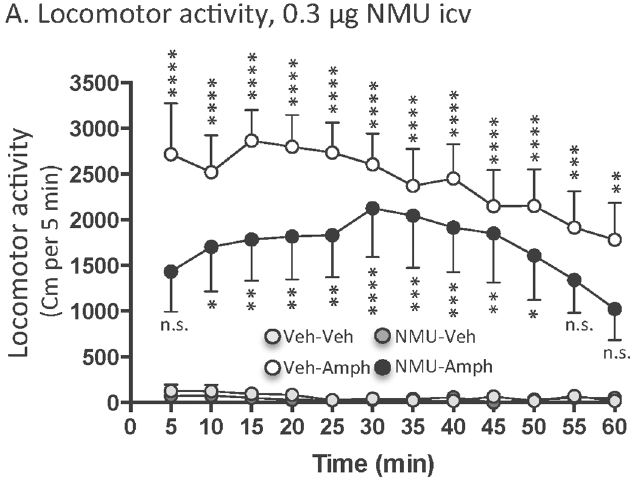
Fig 3. Central (0.3 μ g, icv) administration of NMU reduces amphetamine-induced locomotor stimulation in mice. Amphetamine-induced (2 mg/kg, ip) locomotor stimulation was reduced, but not blocked, by a central injection of a lower does of NMU (0.3 μ g, icv). Central administration of this lower dose of NMU had no effect per se on locomotor activity. Data are presented as mean ± SEM (n.s. P >